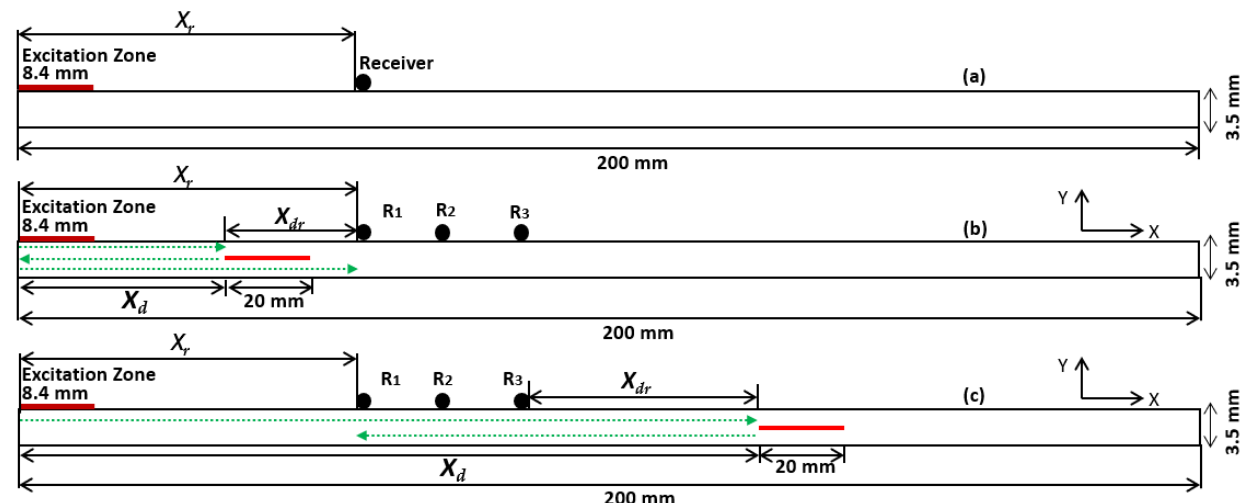
Figure 1. Guided wave inspection setup on a carbon fiber-reinforced polymer (CFRP) plate: